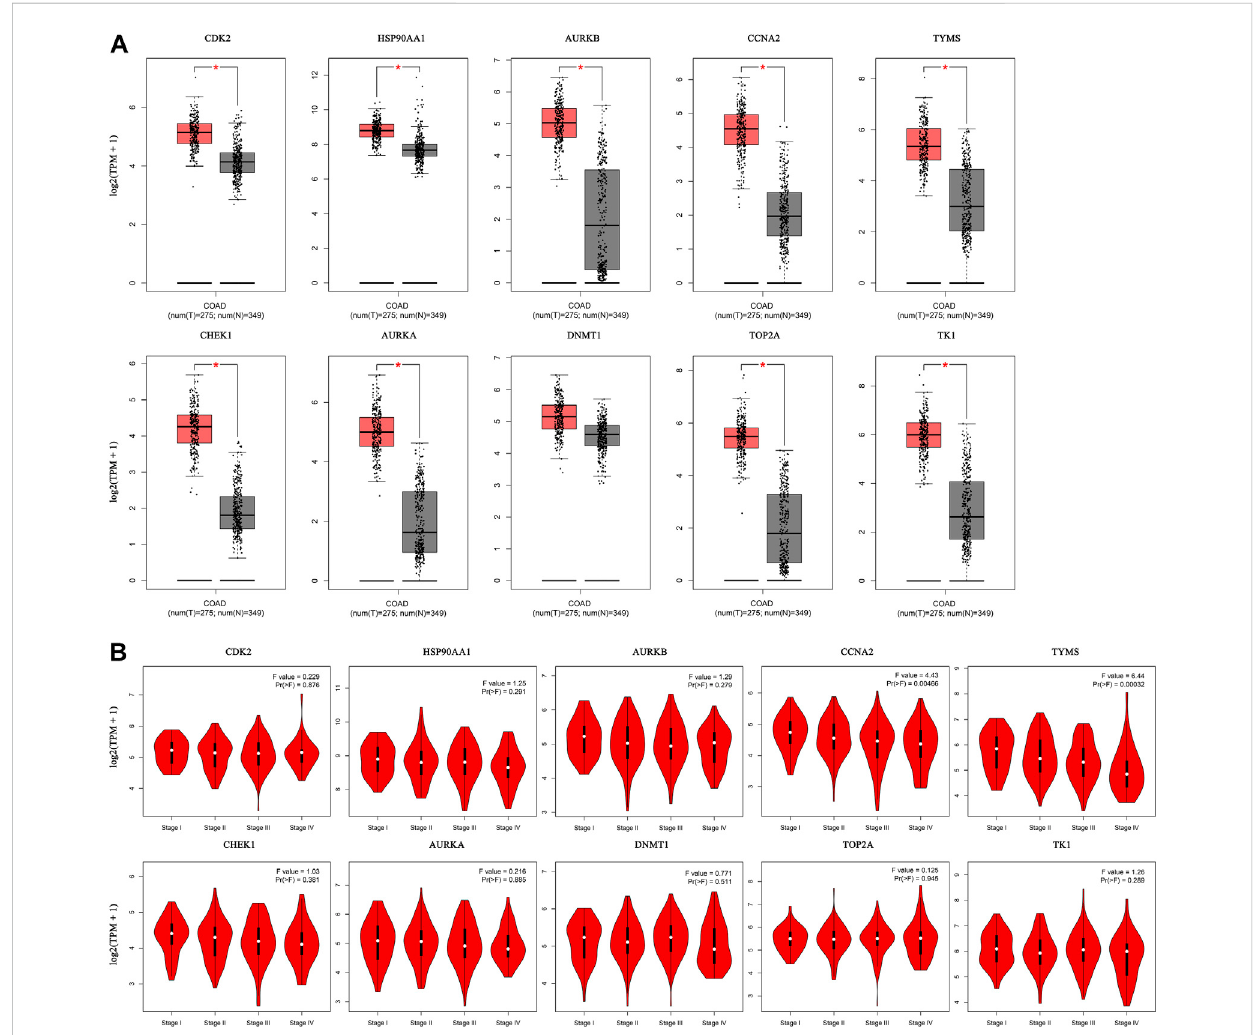
FIGURE 8 Hubgene expressioninthe GEPIA database. ( (A) . Box plotofhub gene mRNA expressionlevels in theGEPIA database.Red represents tumor tissues and gray represents normal tissues. (B) . Stage diagram of hub gene mRNA expression levels and pathological stages in the GEPIA